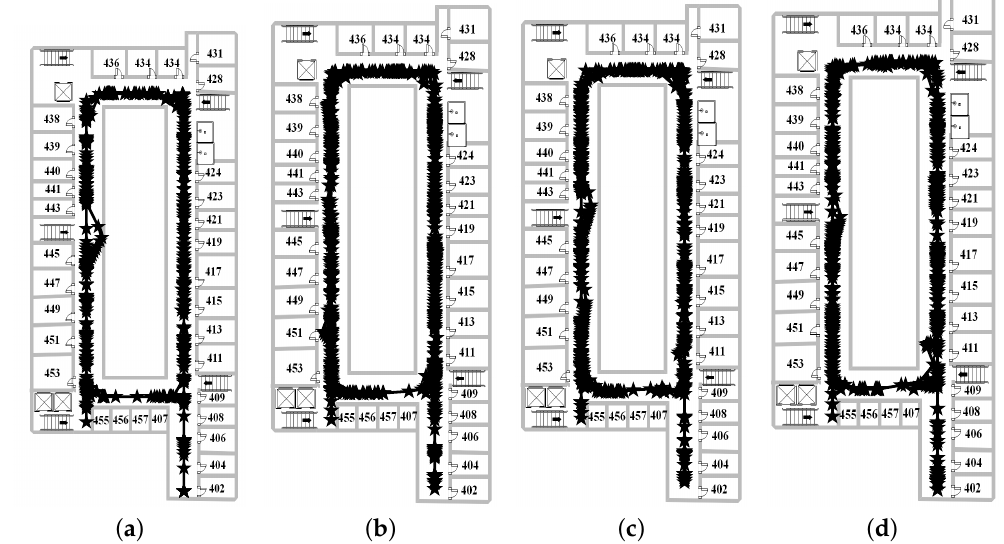
Figure 11. Positioning results for DR/MM in office building: ( a ) calling; ( b ) dangling; ( c ) handheld; and ( d ) pocket.